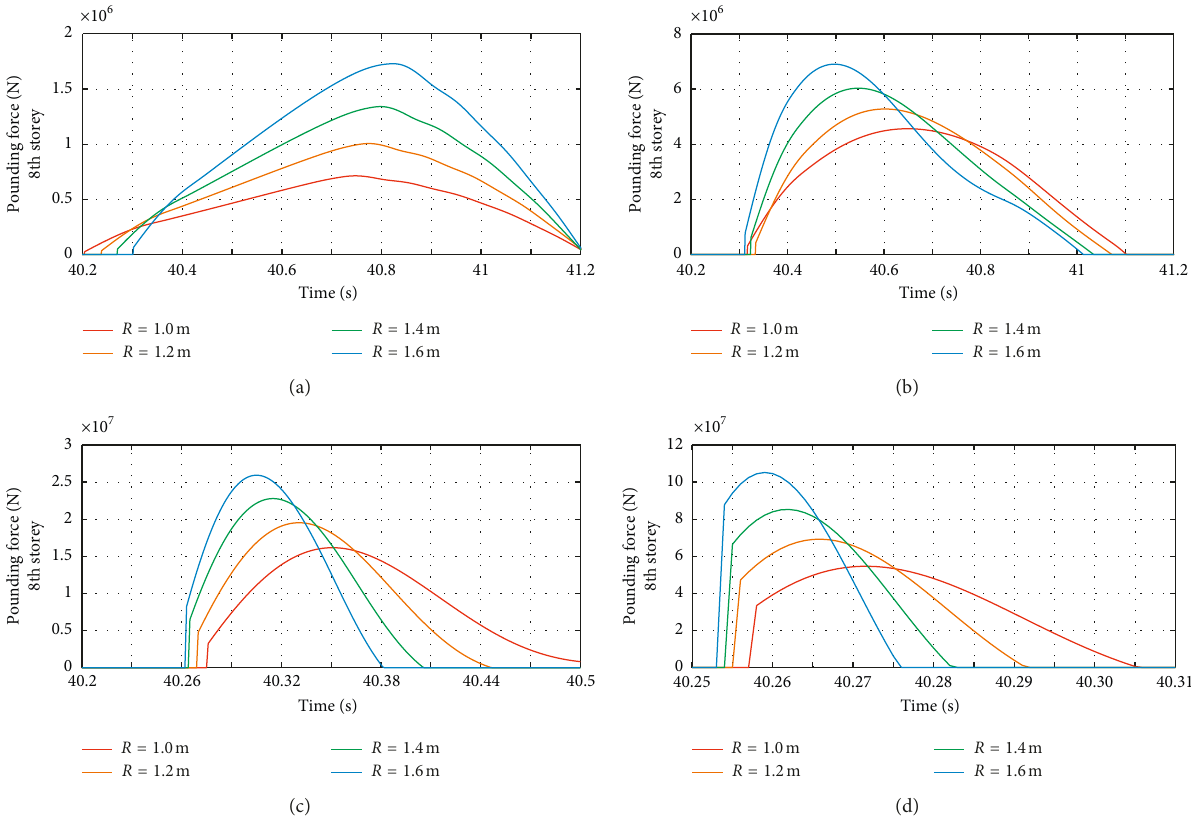
Figure 14: Pounding force time-histories with different polymer bumper sizes during one collision process: (a) Type A material; (b) Type B material; (c) Type C material; (d) Type D material.